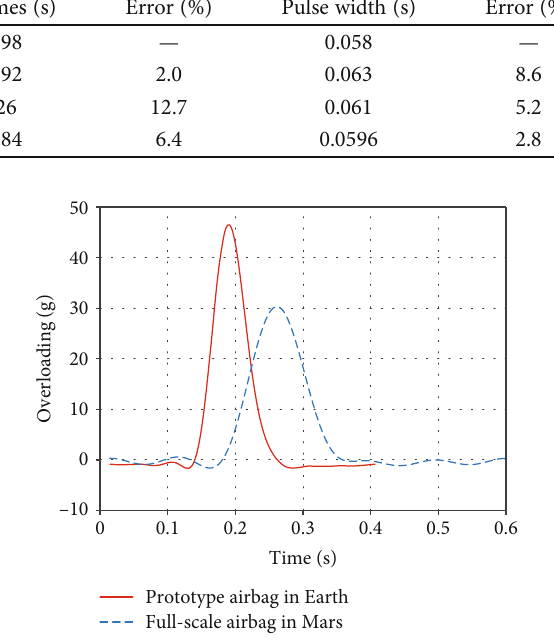
Figure 5: Comparison of the overloading between the full-scale system and the